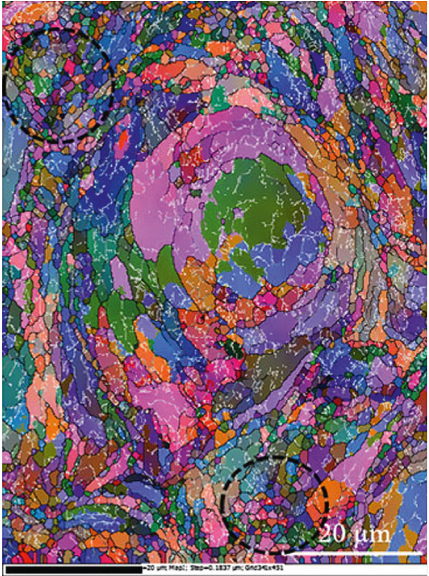
Figure 3: Euler angle EBSD patterns of the cross section of an Al 6061 particle in the cold-sprayed coating